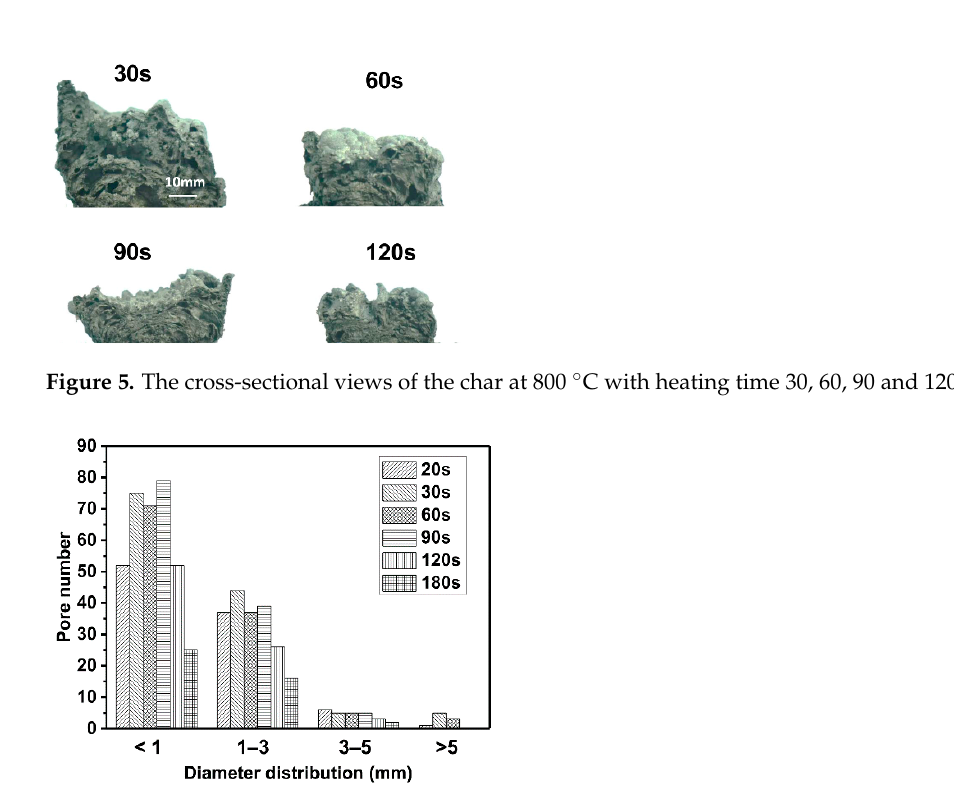
Figure 6. The distribution of the pores of the char at 800 °C with heating time from 20 s to 180 s in a cross-sectional view.